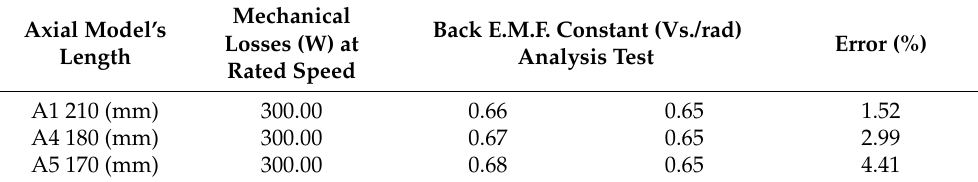
Table 11. Mechanical losses and comparison of back EMF constant.